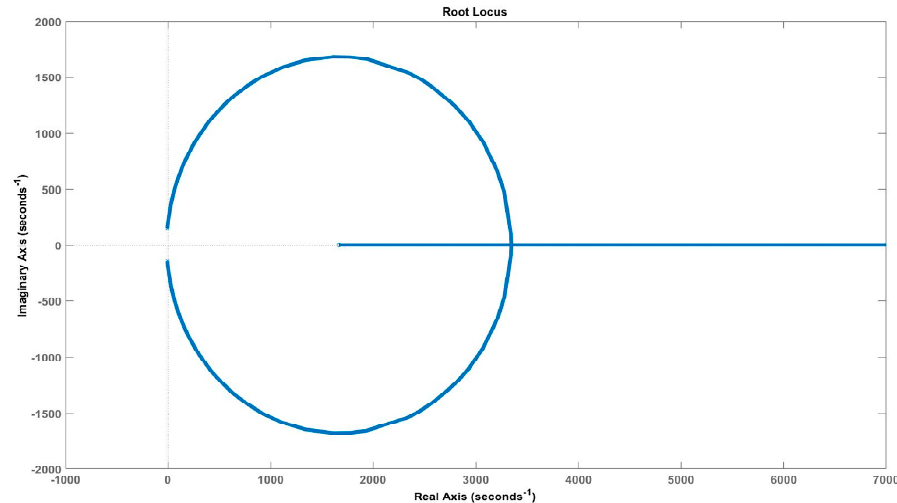
Figure 6. Pole-zero map of the control-to-output voltage transfer function of the system without controller.